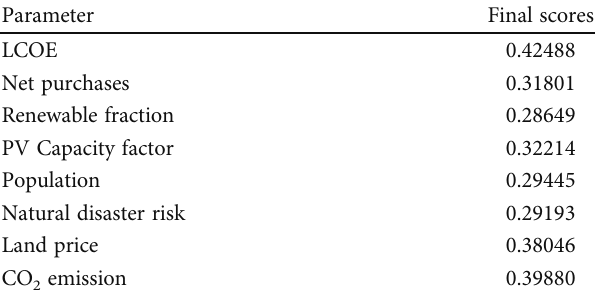
Table 8: Weight of under study